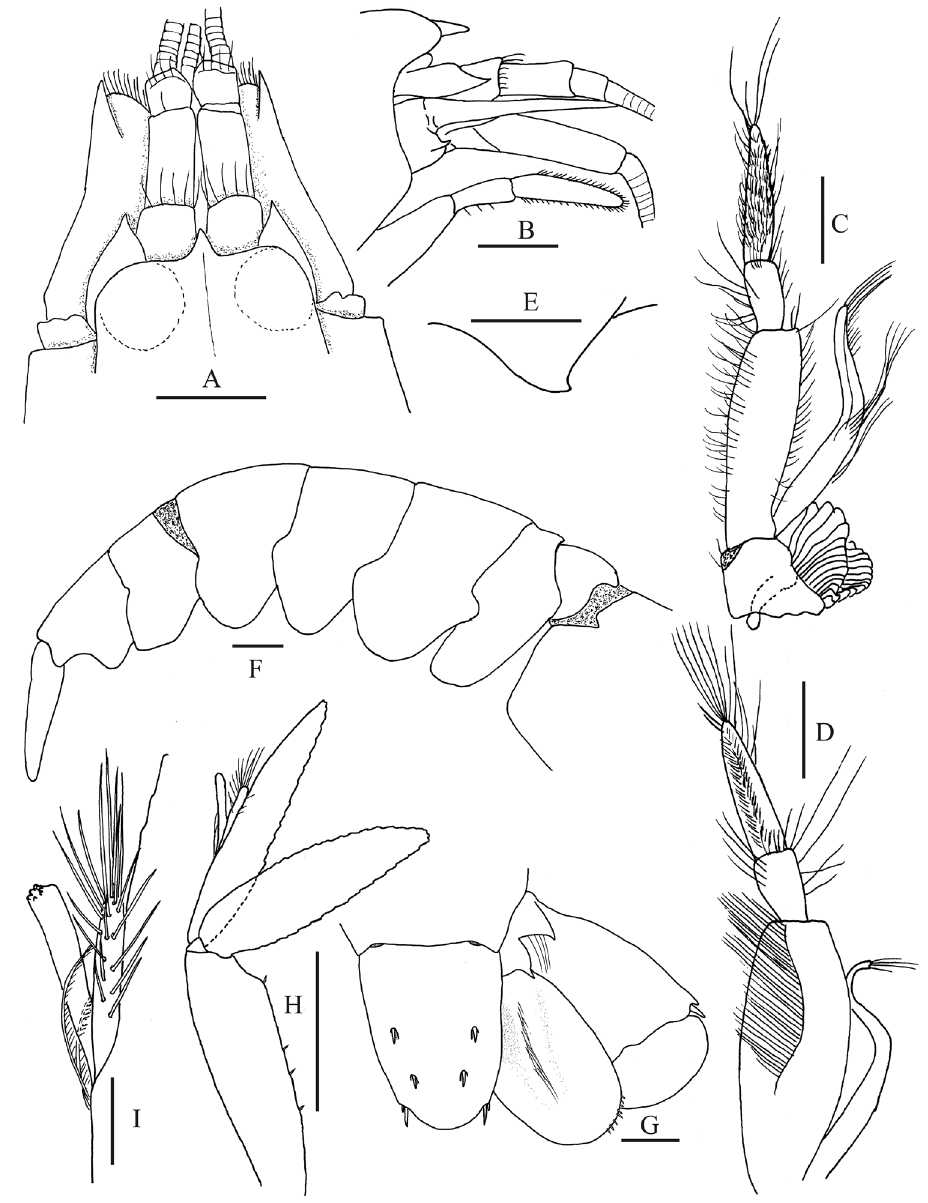
Figure 2. Alpheus margaritae sp. n. Paratype male, CL 6.5 mm ( D, H, I ), (CNCR 32595), Female para- type, CL 7.4 mm ( A–C, E–G ) (EMU-10581); A anterior portion of carapace and cephalic appendages, dorsal view B same in lateral view (setae omitted) C, D third maxilliped E antennular carina F abdomen, lateral view (setae omitted) G telson and uropods, dorsal view (setae partially omitted) H second pleopod I detail of appendices interna and masculina. Scale bars: A–D, F–H 1 mm; E, I 0.2